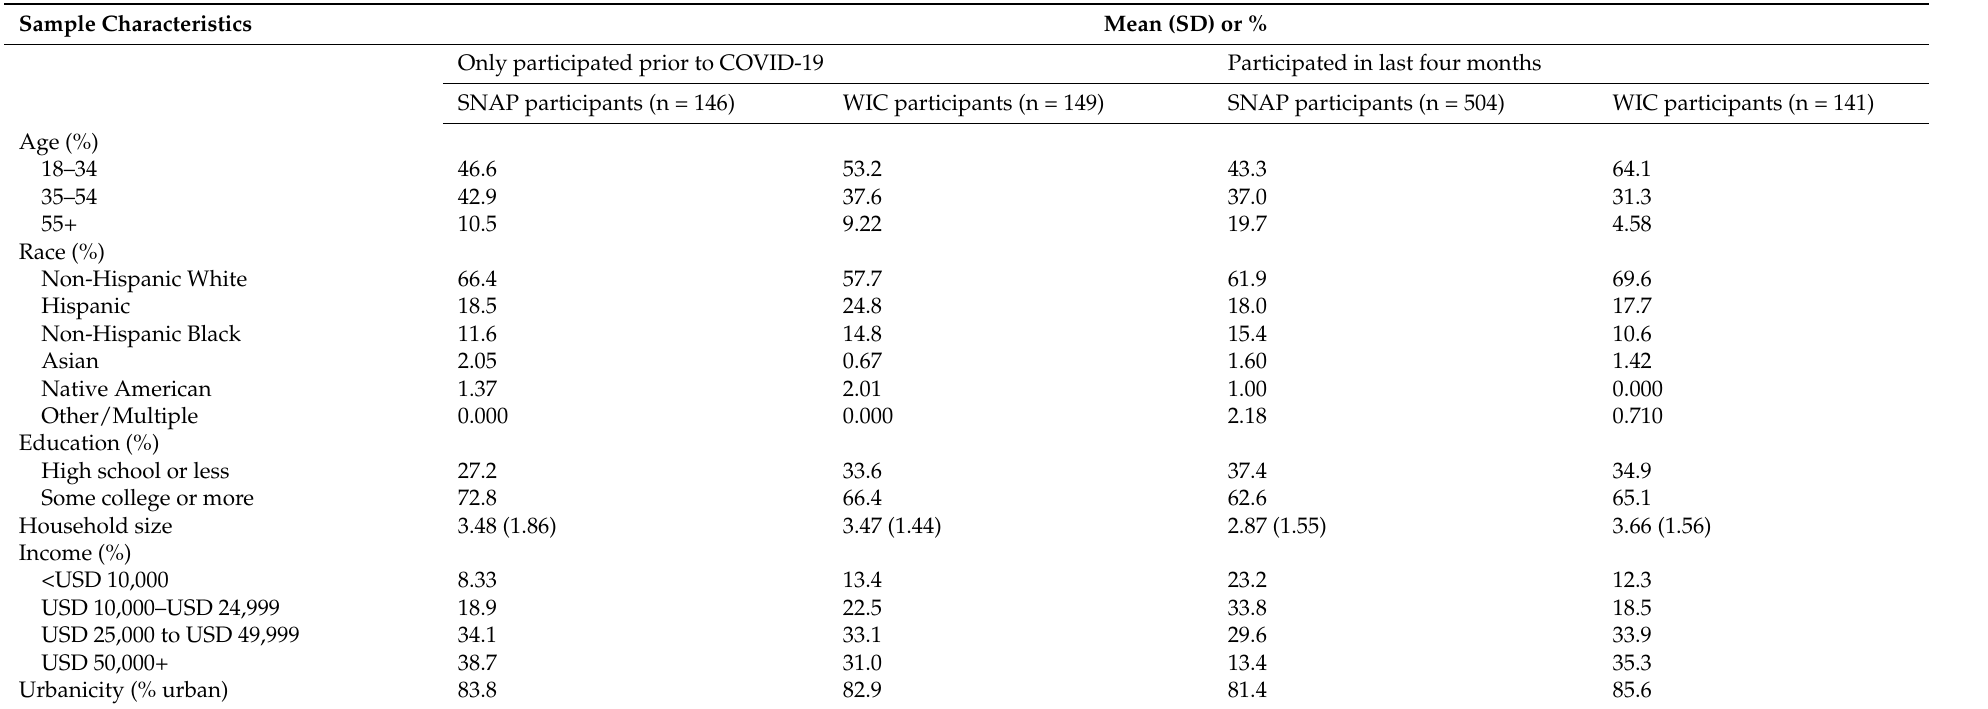
Table 1. Demographics Characteristics of a National Sample of Households that Discontinued Participating in or Participated in the Supplemental Nutrition Assistance Program (SNAP) or the Special Supplemental Nutrition Program for Women, Infants, and Children (WIC) During the Coronavirus Disease 2019 (COVID-19)